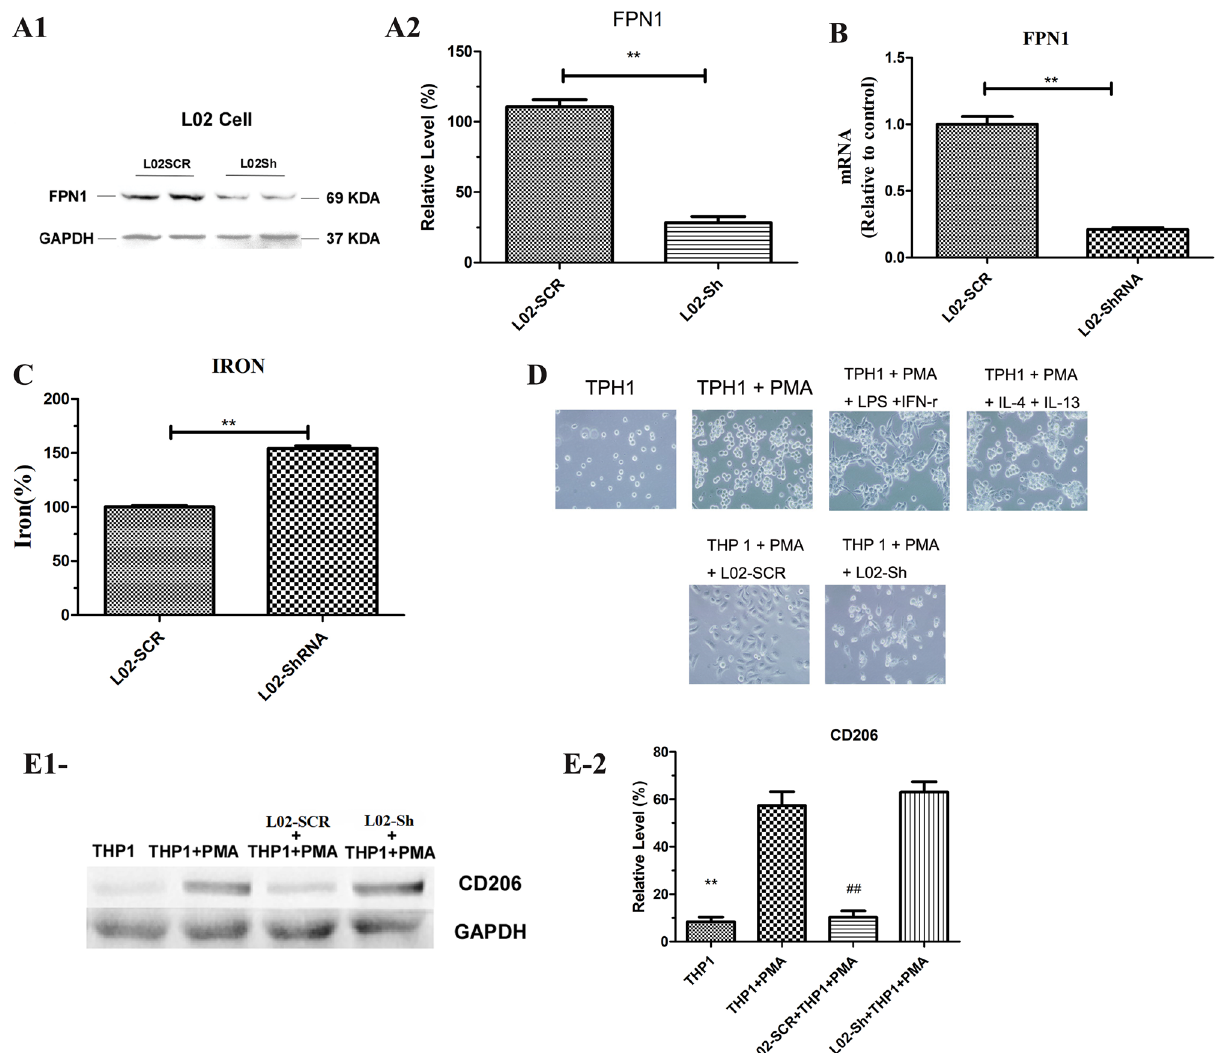
Figure 5. Downregulation of FPN1 in L02 cells promoted M2 macrophage polarization in vitro. Western blot ( A ) and Q-PCR ( B ) analysis of the expression of FPN1 in L02-SCR and L02-Sh cells. ( C ) Iron content in L02- SCR and L02-Sh cells. ( D ) THP-1 cells plated in culture plates were incubated with 160 nM PMA in RPMI 1640 medium containing 5% FBS for 48 h. For M1 macrophage induction, 10 pg/ml LPS and 20 ng/ml IFN-γ were added to the medium without PMA. For M2 macrophage induction, 20 ng/ml IL-4 and 20 ng/ml IL-13 were added to the medium. ( E ) Western blot analysis of CD68 , CD11b , CD206 and iNOS expression in macrophages. (1) Image of western blot; (2) Grey level of western blot. All results are from three independent experiments. ** P < 0.001. ** P < 0.001, vs THP1 + PMA. ## P < 0.001, vs L02-Sh + THP1 +